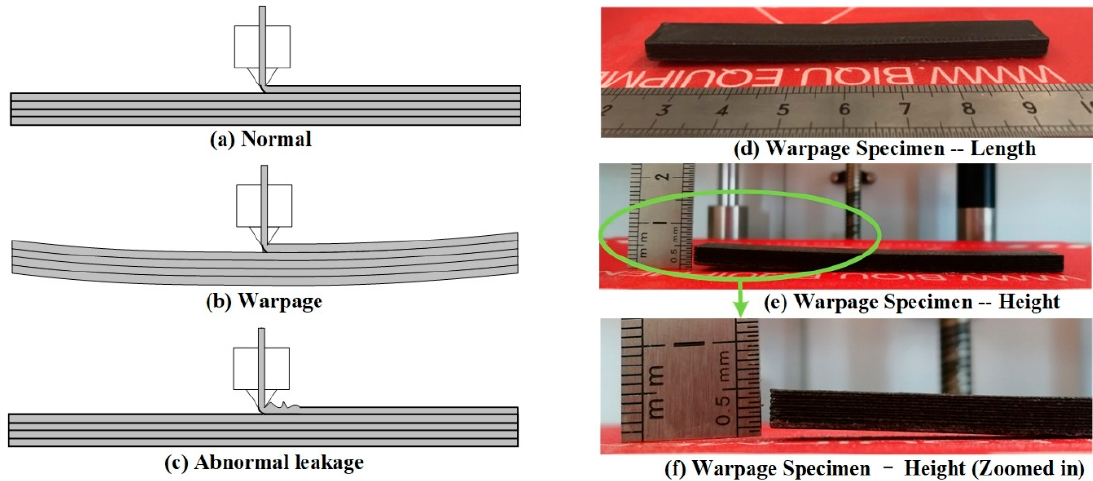
Figure 4. Normal, warpage, and material stack caused by abnormal leakage: ( a ) the normal; ( b ) warpage; ( c ) abnormal leakage; ( d ) the length of warpage specimen; ( e ) the height of warpage; ( f ) the zoomed-in warpage.